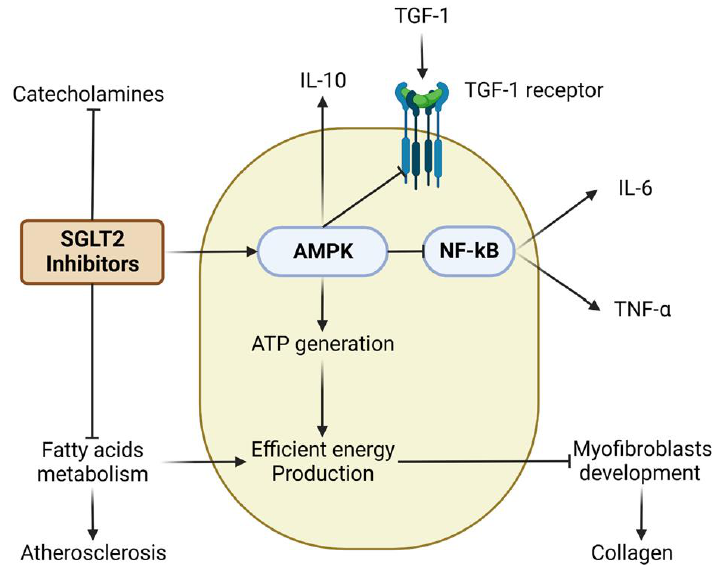
Figure 2. Cardiac effects of SGLT2 inhibitors.